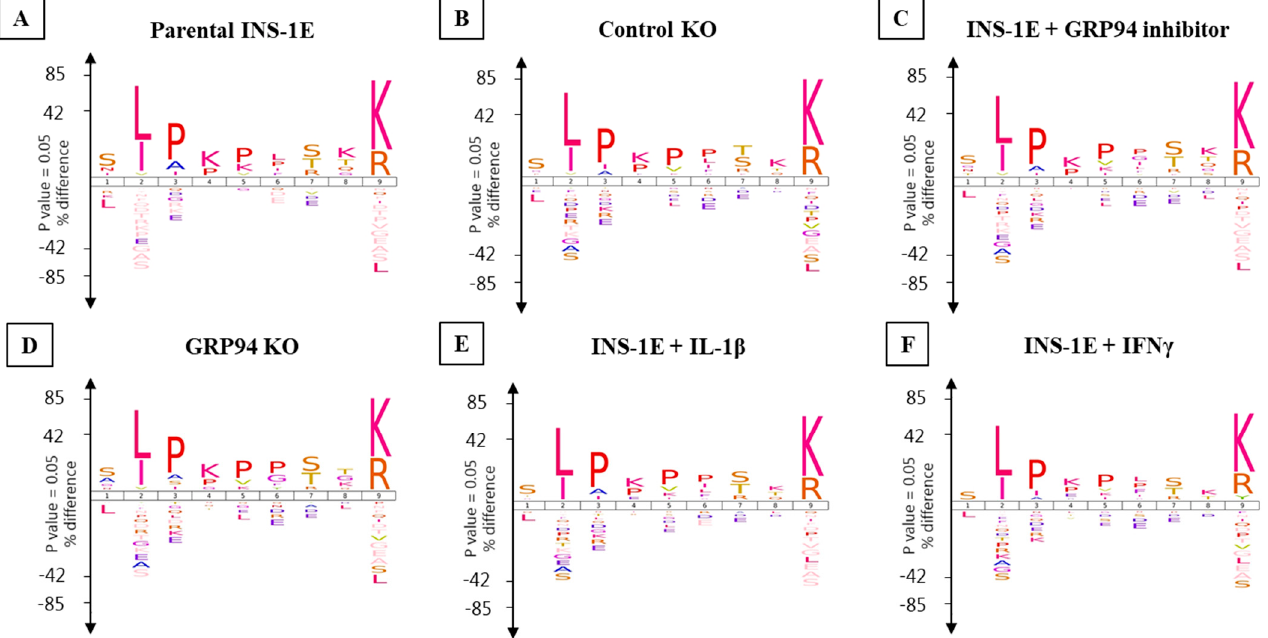
Figure 5. Nonamers binding motif for INS-1E cells under tested conditions. ( A ) Parental INS-1E, ( B ) control GRP94 KO clone, ( C ) INS-1E treated with GRP94 inhibitor (20 µM for 24 h), ( D ) GRP94 KO INS-1E clone, ( E ) IL-1 β exposure (15 pg/mL for 24 h), and ( F ) IFN γ exposure (10 ng/mL for 24 h). n = 2 for all except GRP94 KO where n = 4.